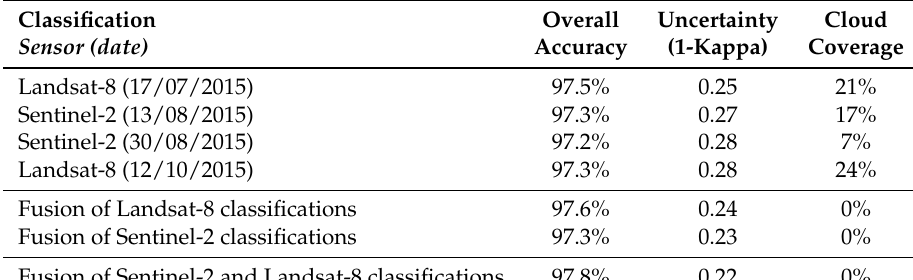
Figure 6. Results at various steps of the approach for Rennes city. Table 2. Intermediate result for